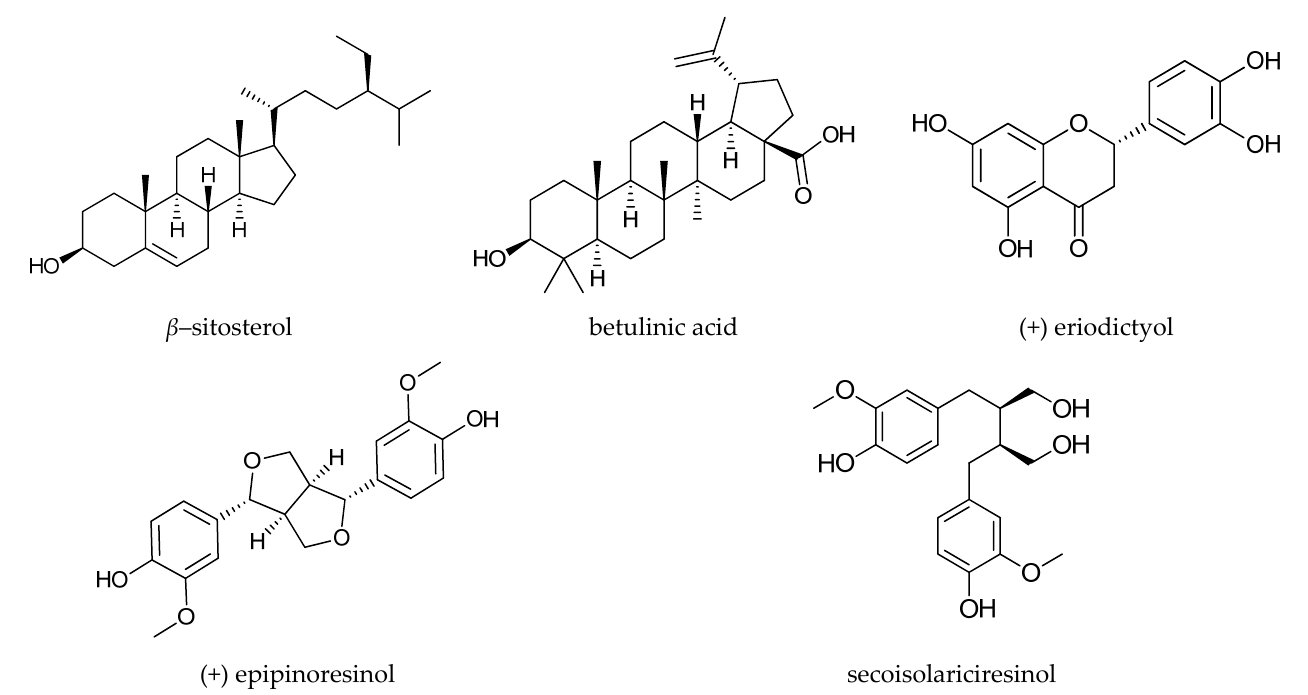
Figure 1. Structures of the analyzed compounds.